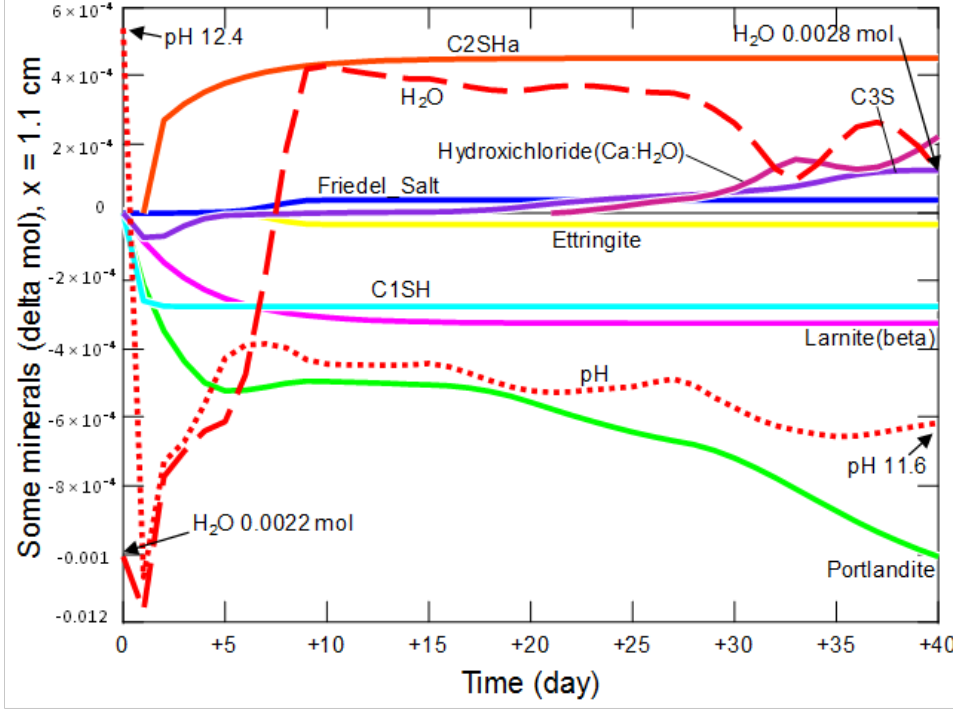
Figure 21. Changes in the amount of water, mineral phases and pH in the cement matrix at a distance of 1.1 cm from the beginning of the model domain in conditions of ammonium chloride penetration.